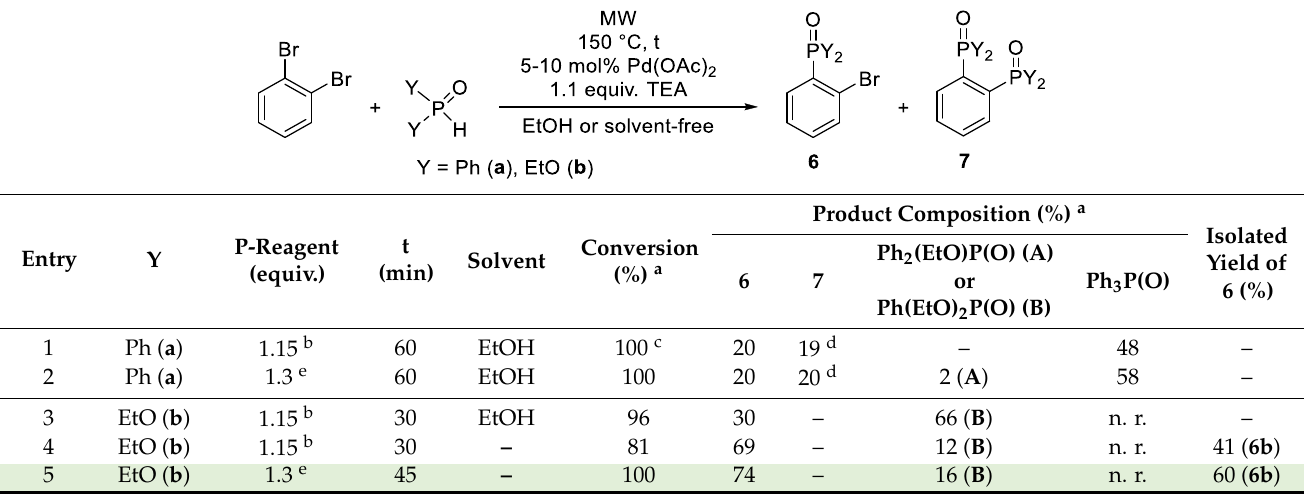
Table 7. P–C coupling reactions of 1,2-dibromobenzene. Table 7. P – C coupling reactions of